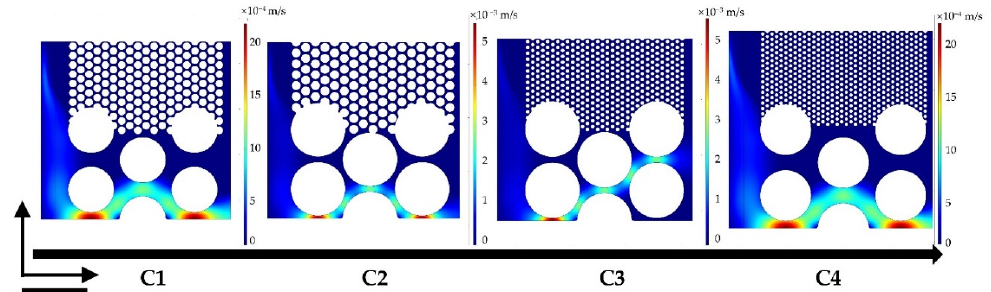
Figure 3. Velocity distribution of chips (from left to right: C1; C2; C3; C4), C1 is short for chip 1, C2 is short for chip 2, C3 is short for chip 3, C4 is short for chip 4, red represents high velocity, and blue represents low velocity. The scale bar is 1 mm.